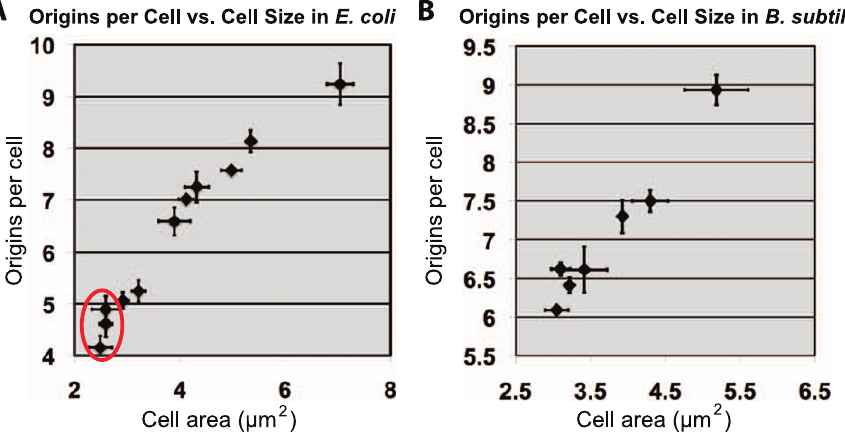
Figure 5. Increasing cell size results in proportional increase of initiations for both E.coli and B.subtilis . (A & B) Scatter plots of cell size versus replication origins. (A) An E. coli or (B) B. subtilis strain either overexpressing or depleting the essential division protein FtsZ (see Figure S3 for FtsZ expression levels). Cell origin numbers were determined by examining DNA content post replication run-out by flow cytometry. The median of the population (counts . 200) was used for size. Error equals one standard deviation (n=3). Red circle in ‘‘A’’ denotes E. coli cells that are smaller than wild type due to increased levels of FtsZ.